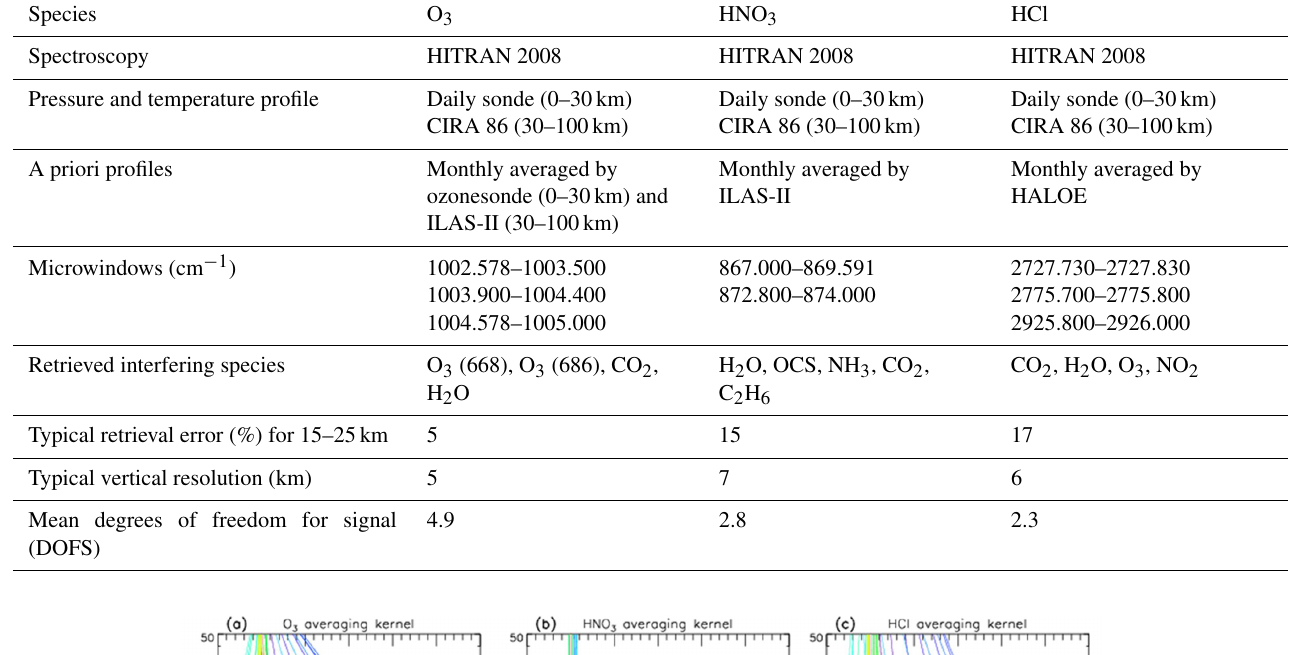
Table 1. Retrieval parameters of SFIT2.